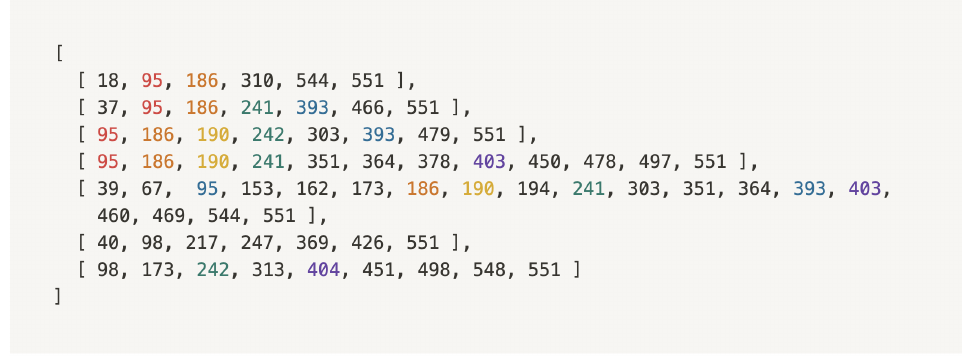
Figure 21. Topic segmentation points in ‘basic income’.